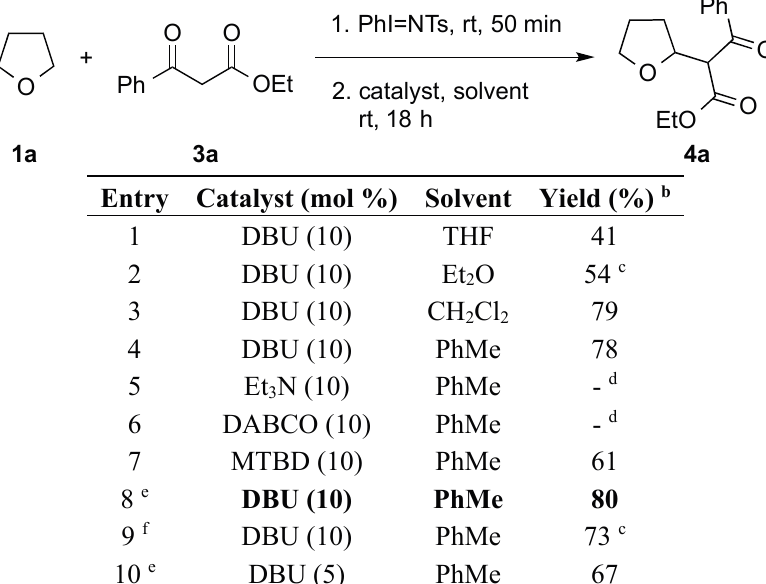
Table 1. Optimization of reaction conditions a